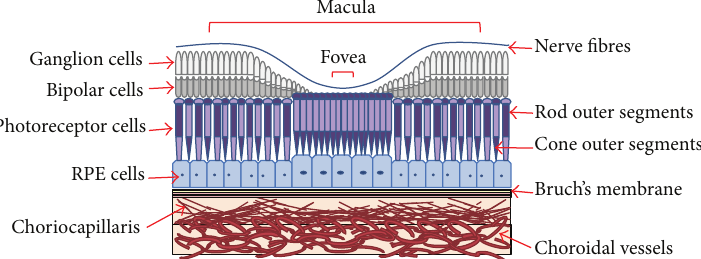
Figure 2: Diagram of the structure of the ocular fundus consisting of macula, fovea, photoreceptor cells, retinal pigmented epithelial (RPE) cells, Bruch’s membrane, and choroidal vessels. The macula in the central retina is the key site for AMD. Two types of photoreceptors, rods and cone outer segments, and RPE cells are affected in AMD. Bruch’s membrane consists of five layers and acts as a natural barrier enabling the transport of nutrients and oxygen inwards and removal of waste outwards. Choroidal vessels are lined with endothelial cells and provide the entry and exit point of nutrients and waste to the different layers of the macula.